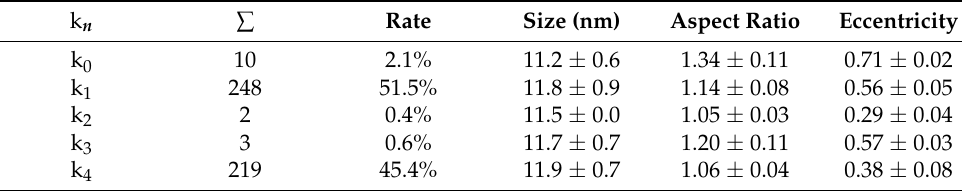
Table 2. Clustering summary for the QD size and shape analysis. k n is the cluster number, ∑ and rate are the number and the fraction of particles for each cluster. Size, aspect ratio and eccentricity represent the mean size (diameter), the mean aspect ratio and the mean eccentricity of the particles for each cluster. k n ∑ Rate Size (nm) Aspect Ratio Eccentricity k 0